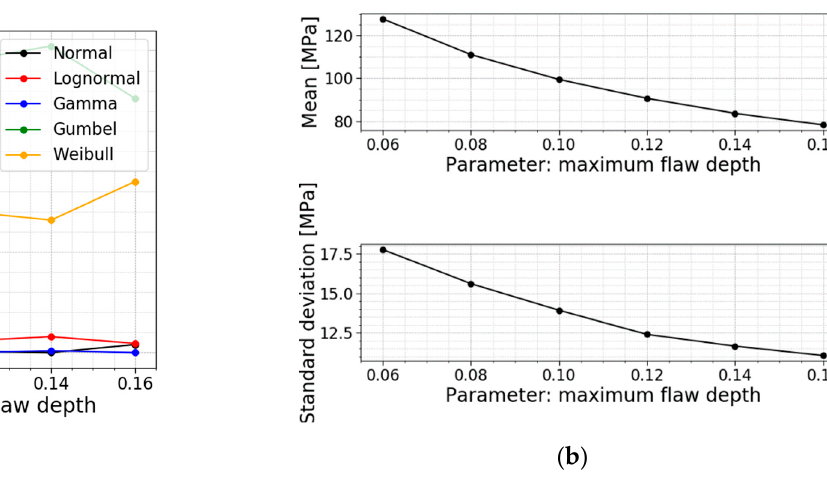
Figure 26. ( a ) AIC values and ( b ) the mean and st.dev. of the normal stress at failure for a varying maximum flaw depth.